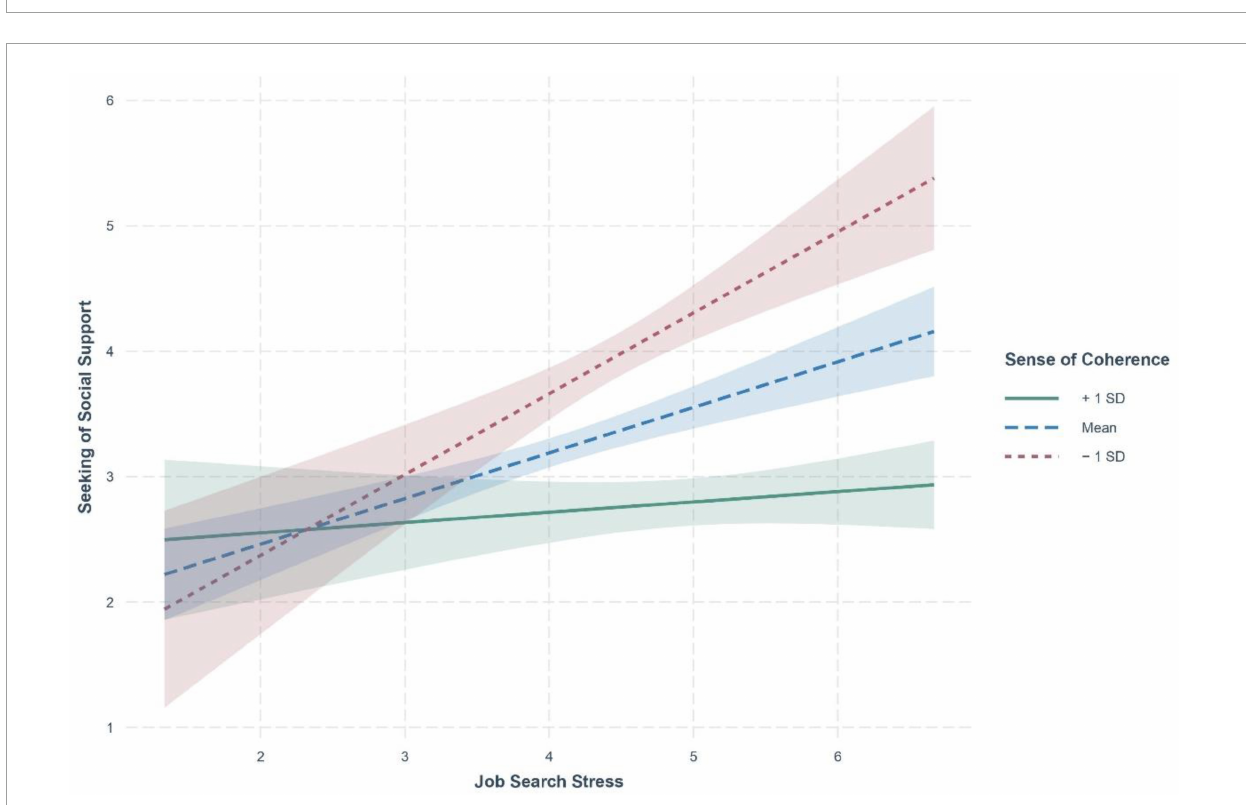
FIGURE3 Johnson-Neyman plot presenting the interaction effect between job search stress and sense of